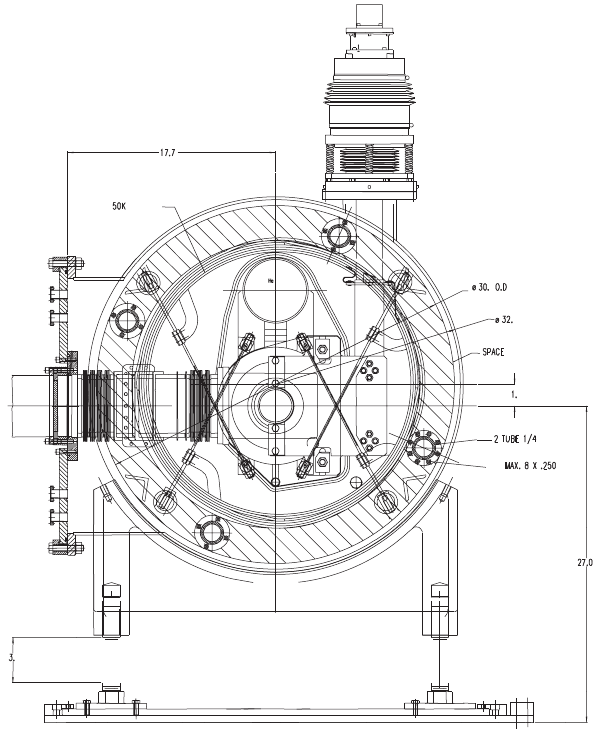
FIG. 23. Cross section of Mk II CEBAF cryomodule.